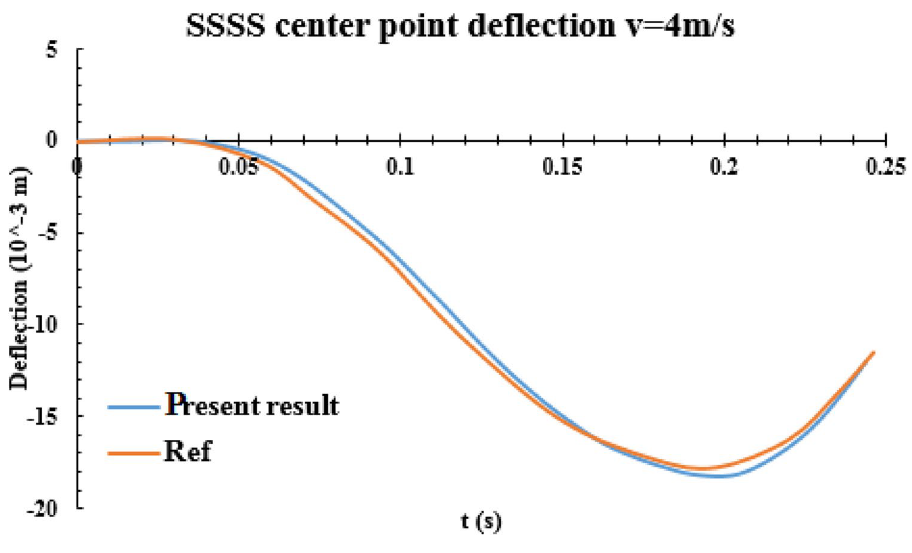
Fig. 4 Nonlinear transient deflection of plate compared with Ref [44] for CCCC bound- ary